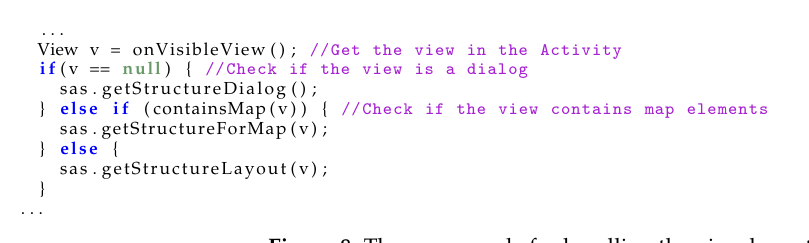
Figure 8. The source code for handling the view